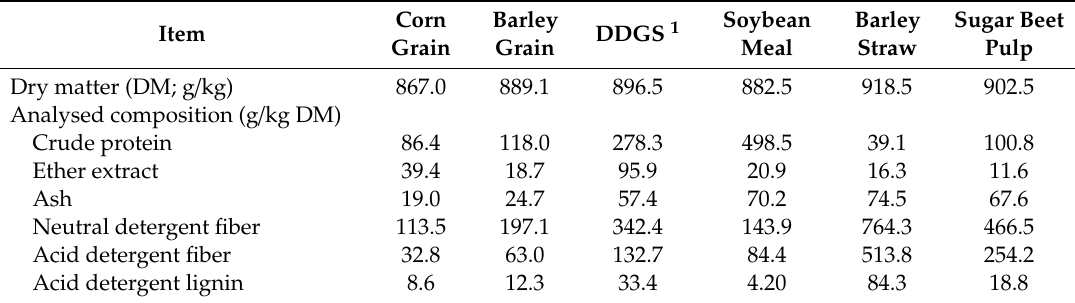
Table 2. The chemical composition of the substrates used in the degradability